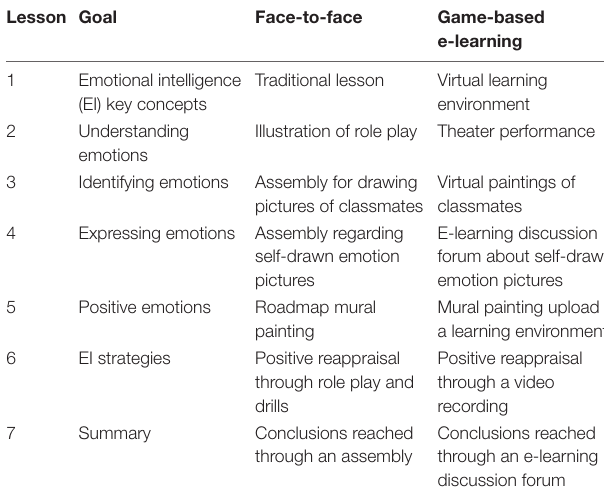
TABLE 1 | Content, methods, and characteristics of the 7-week teacher training program. Lesson Goal